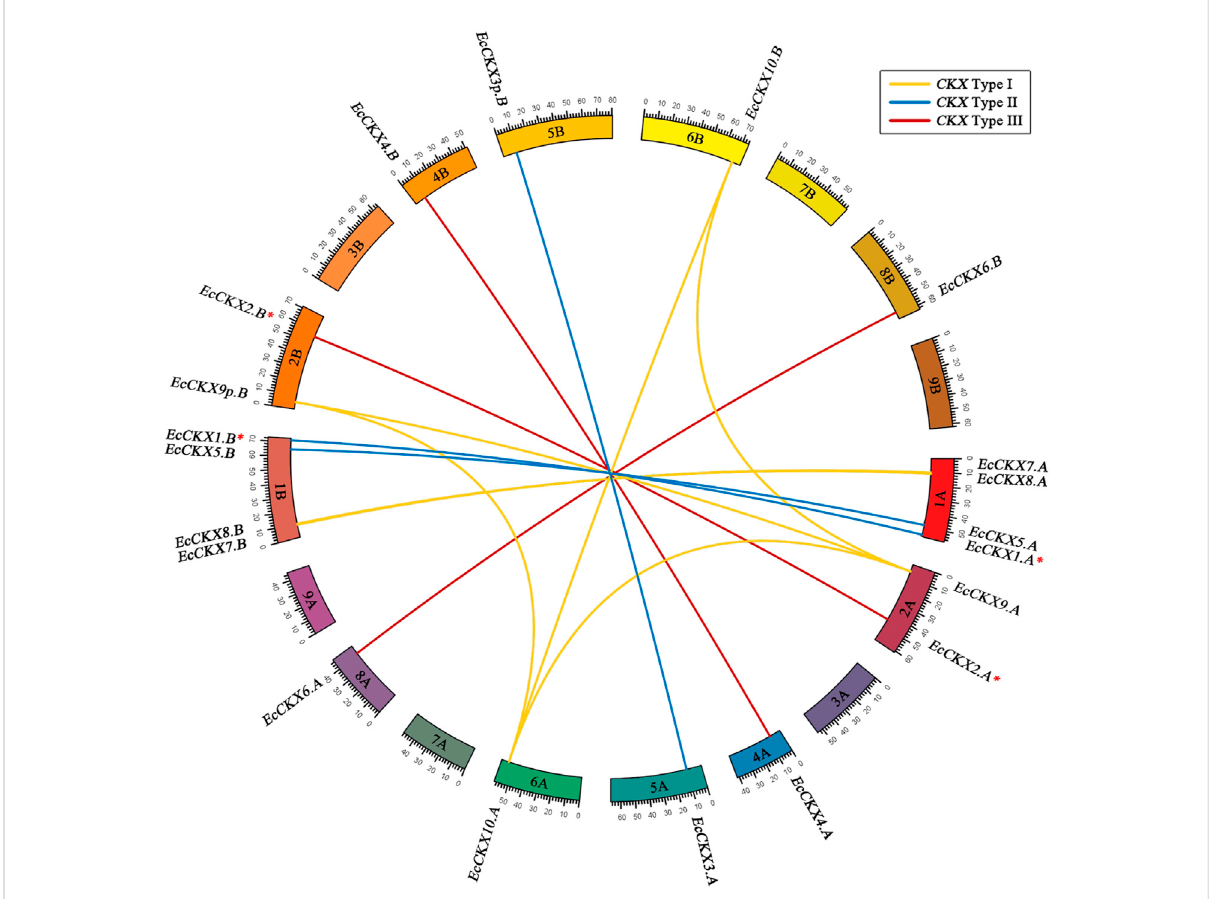
FIGURE 6 Synteny analysis of interchromosomal relationships of EcCKX of various types from different subgenomes of E. coracana . Syntenic gene pairs are colored according to the type of CKX, to which they are attributed. A red asterix denotes genes identical to previously sequenced and characterized EcCKX1 and EcCKX2